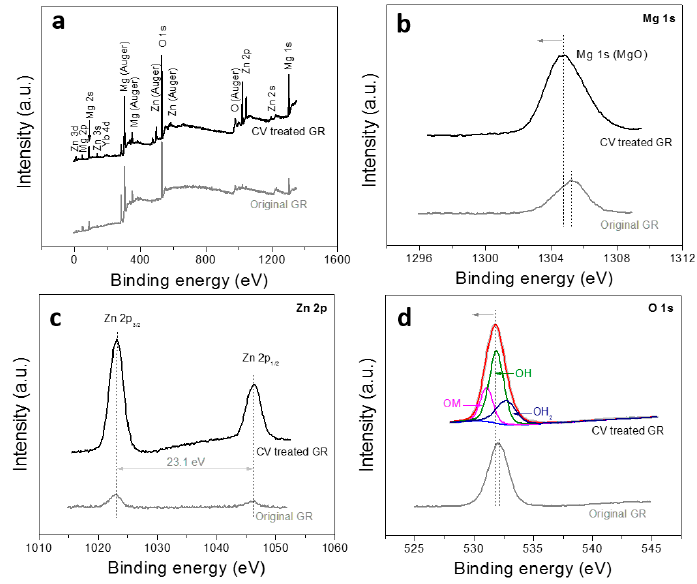
Figure 7. XPS spectra of the nanoplate film: ( a ) fully scanned spectra; ( b ) Mg 1s spectra; ( c ) Zn 2p spectra; ( d ) O 1s spectra.